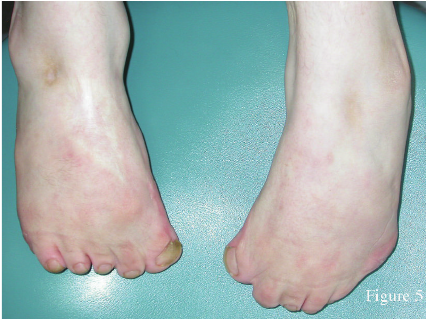
Figure 5: Feet of the patient. Note bilateral talipes equinovarus.